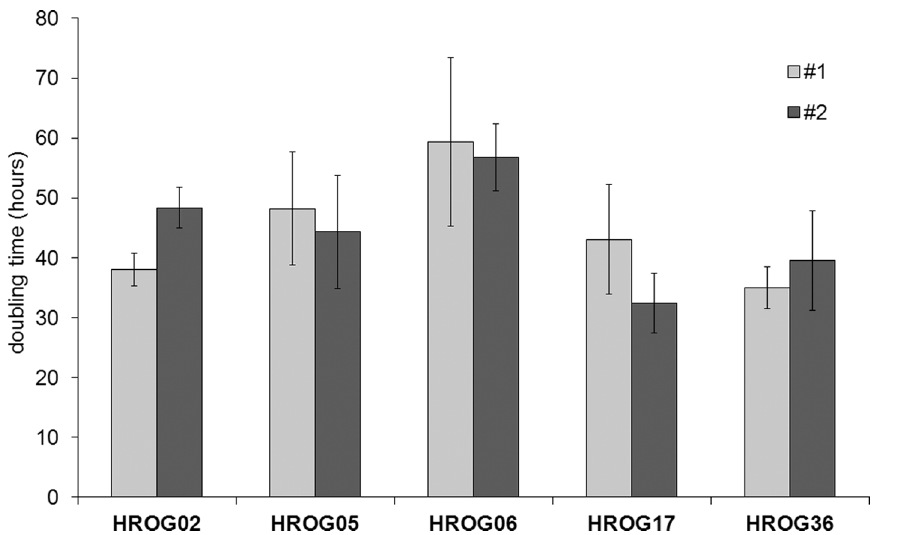
Figure 2. Doubling times. Mean doubling times for the cell lines are displayed placing the pairs side by side. The doubling time for each cell line was determined three times; the mean doubling time (in h) and standard deviation were calculated and depicted in a bar chart.